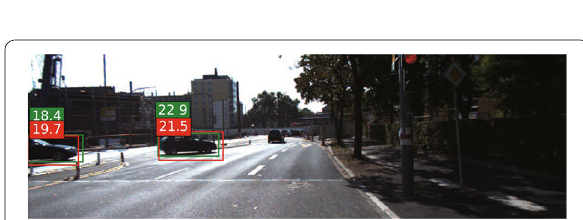
Fig. 15 Examples of estimated distance for the side-view of cars in KITTI dataset. The ground truth distance and estimated distance are written in green and red boxes respectively. The unit of distance is meter. Only BBs with IoU ≥ 0.7 are shown